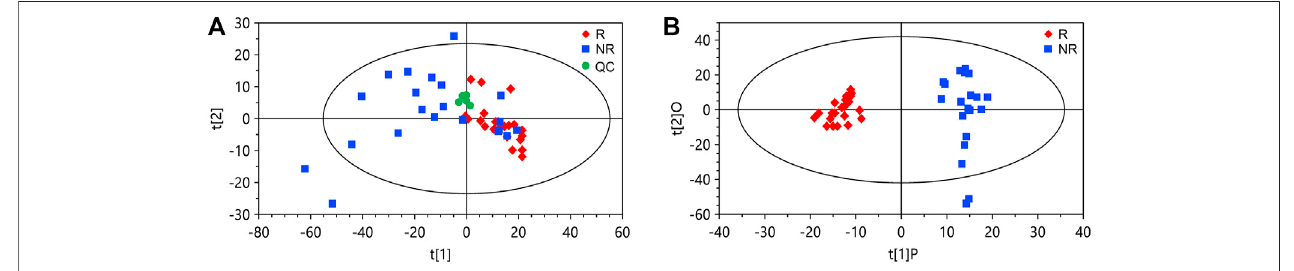
FIGURE 1 | Principal component analysis (PCA) and orthogonal partial least squares discriminant analysis (OPLS-DA) of the data from the discovery set. (A) PCA score plot. (B) OPLS-DA score plot. The cumulative R 2 Y and Q 2 Y of the OPLS-DA model are 0.92 and 0.67, respectively. R, responders; NR, non-responders; QC, quality control.